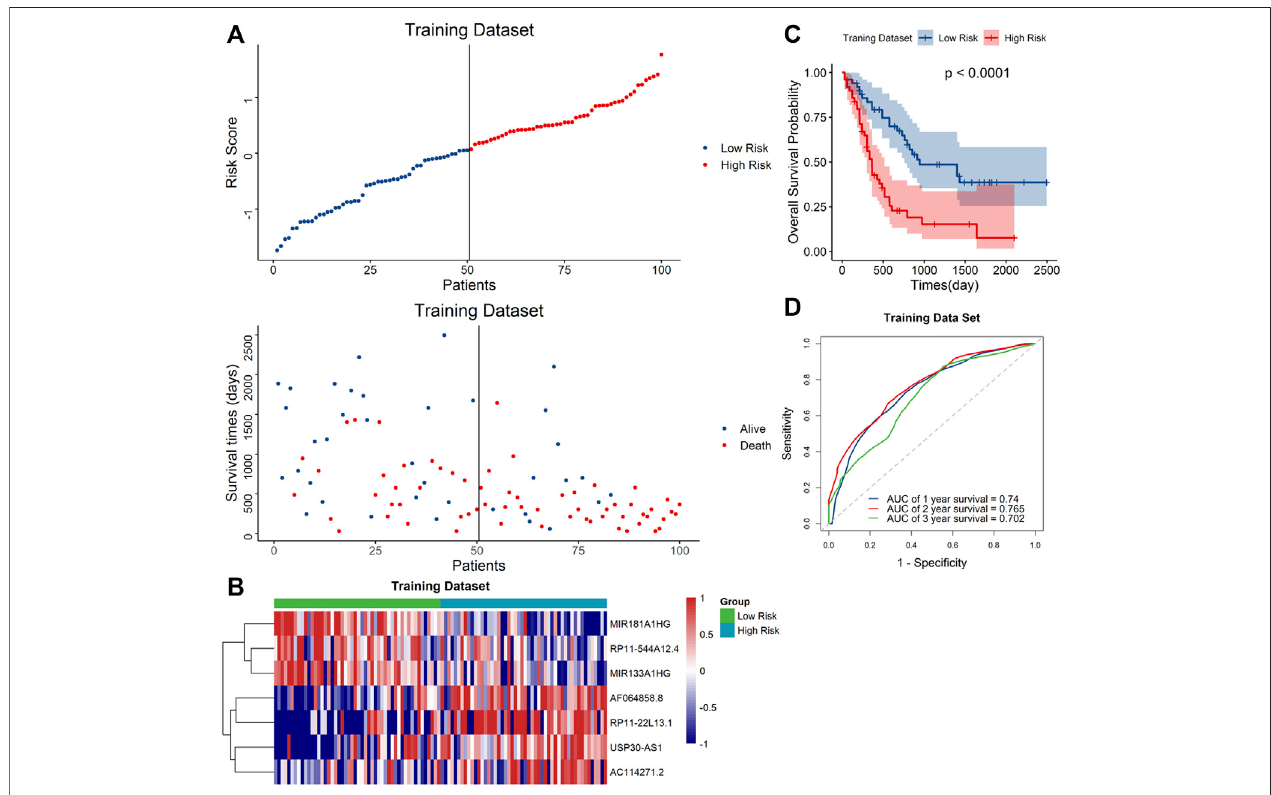
FIGURE 3 | Validation of the signature in the training dataset (A) . Distribution of the risk score (top) and survival time of each patient (down). (B) Expression of the seven lncRNAs in the two risk groups. (C) Kaplan – Meier curve shows results of survival analysis for the signature in training dataset. (D) ROC curves analysis and the AUC values of 1-, 2-, and 3-year survival prediction in training